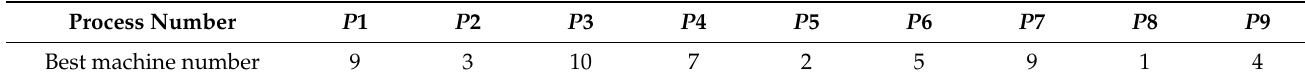
Table 9. Best machine for each process of the knuckle joint assembly.